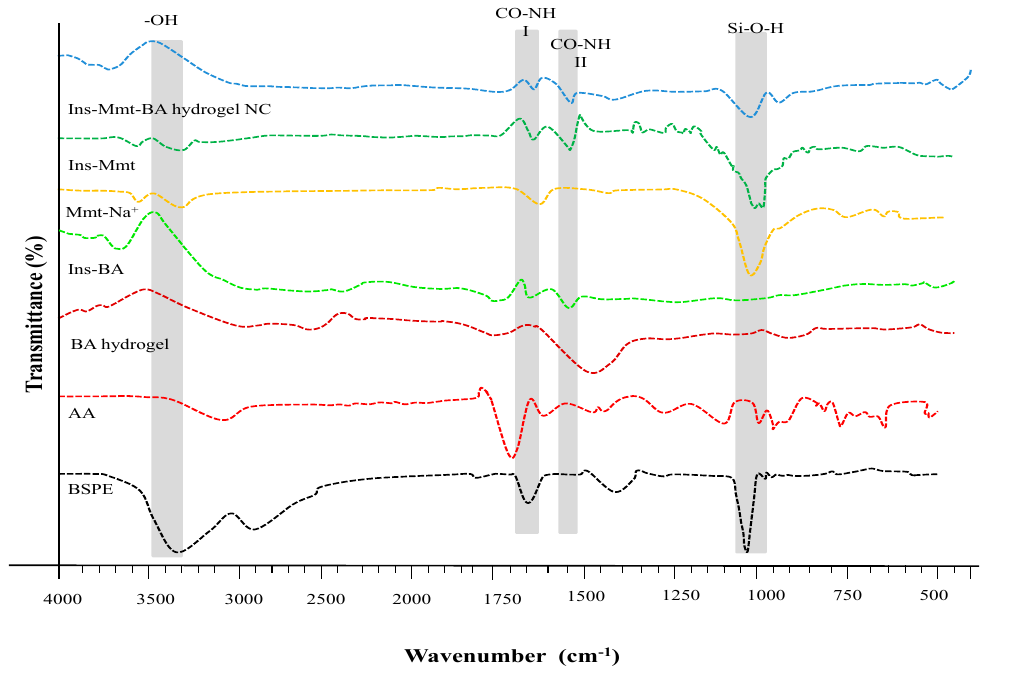
Figure 4. FTIR spectrum overlay of BSPE, AA, BA hydrogel, Mmt – Na + clay, Ins–Mmt, Ins–BA hydrogel and Ins–Mmt–BA hydrogel NC.